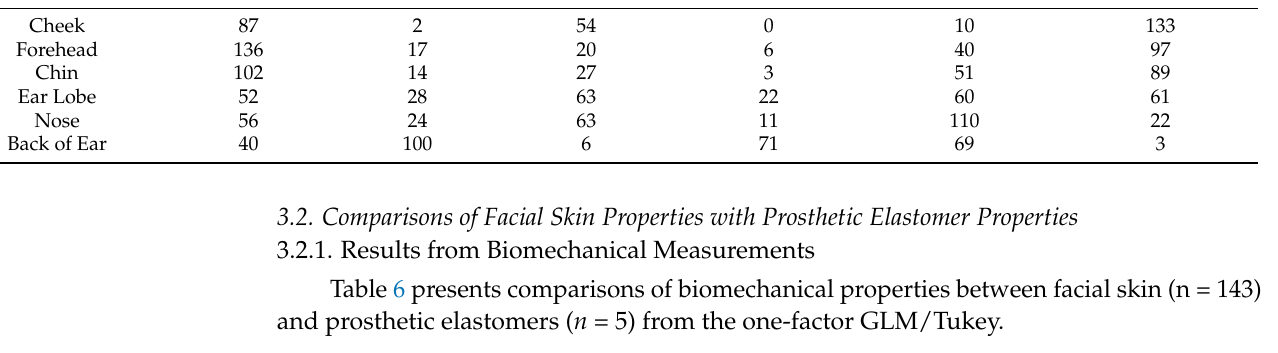
Table 6. Biomechanical properties comparisons among facial skin and prosthetic elastomers